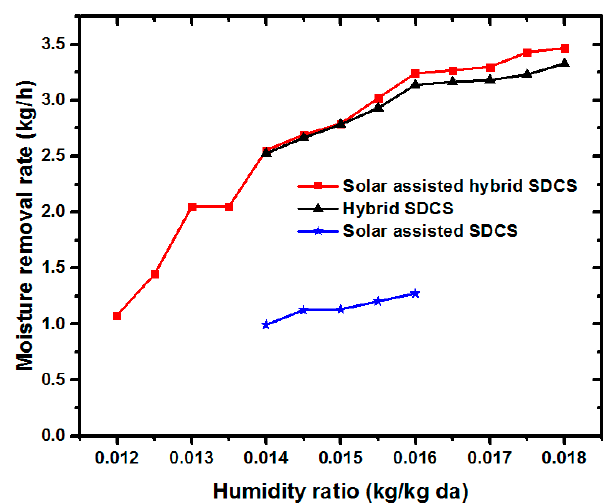
Figure 7. E ff ect of outdoor humidity ratio on moisture removal rate ( MRR Figure 7. Effect of outdoor humidity ratio on moisture removal rate ( MRR ).